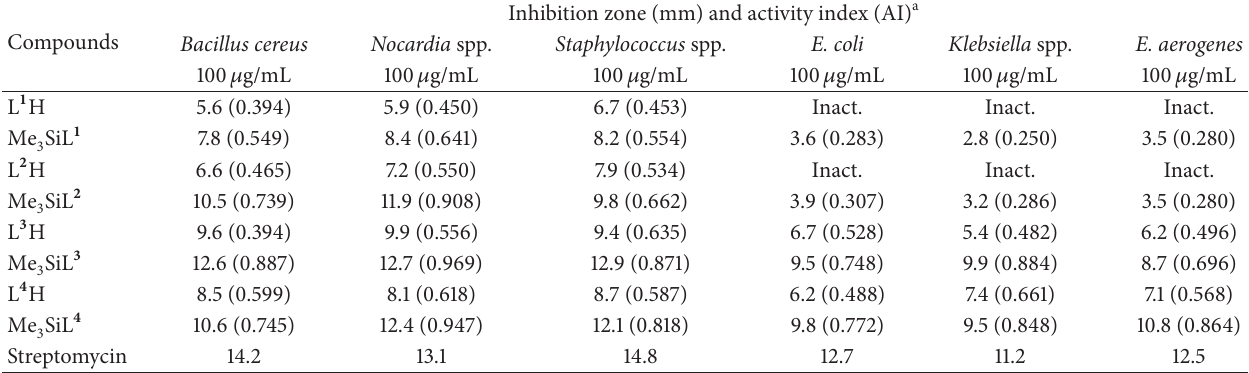
Table 5: Antibacterial activity of ligands and their organosilicon(IV) complexes. Compounds